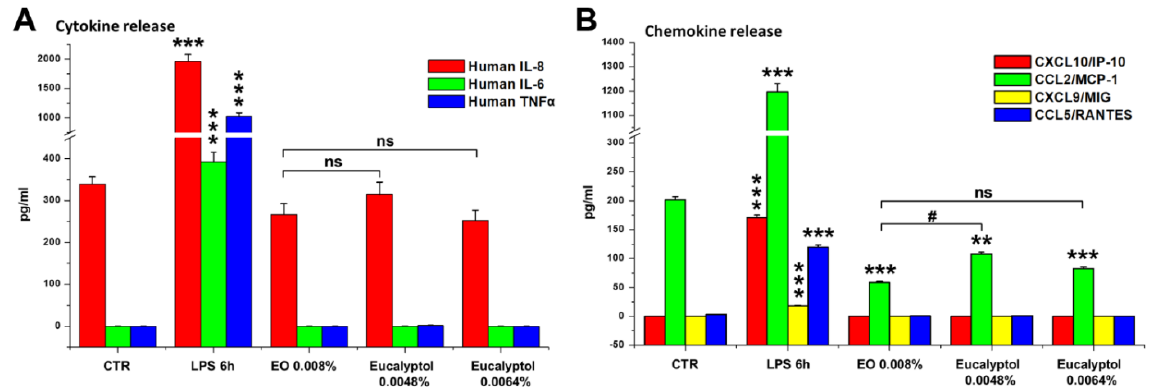
Figure 2. Effect of Eucalyptus oil and 1,8-cineole (eucalyptol) treatments on pro-inflammatory cytokines ( A ) and chemokines ( B ). Analysis by cytometric bead array of the human cytokines IL-8, IL-6, IL-10, and TNF- α ( A ), and chemokines CXCL10/IP10, CCL2/MCP-1, CXCL9/MIG, and CCL5/RANTES ( B ) released in culture medium by the untreated control (CTR); MDMs stimulated for 6 h with LPS and cells treated for 24 h with 0.008% EO, 0.0048% or 0.0064% eucalyptol. Significance (One-way ANOVA + Tukey multiple comparison test), * vs. CTR: ** p < 0.01, *** p < 0.001; # vs. EO: # p < 0.05; ns: not significant.